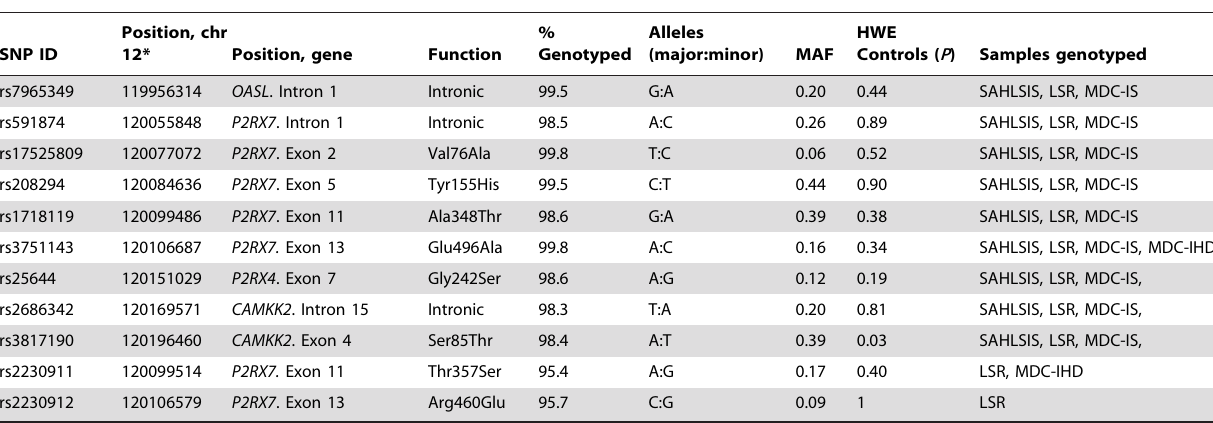
Table 2. Description of SNPs included in the